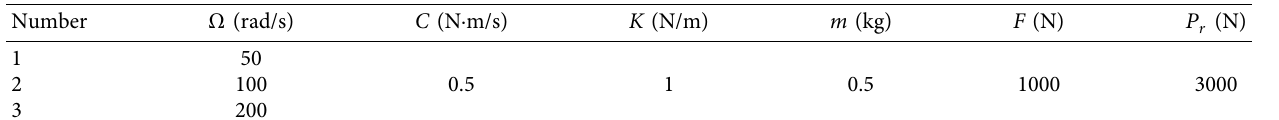
Table 3: Calculation